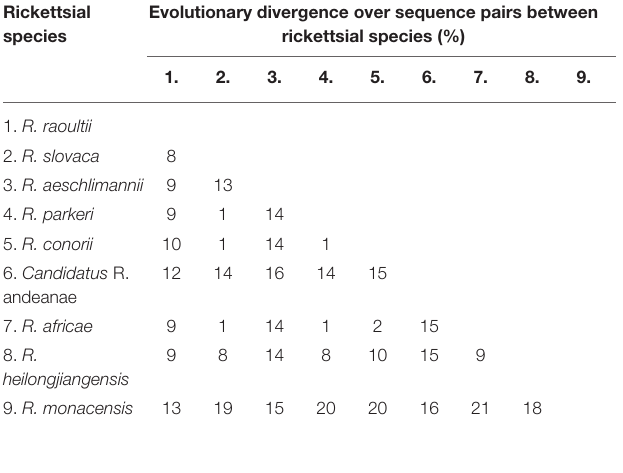
TABLE 5 | Genetic distance matrix among various Rickettsia species in a phylogenetic tree based on the ompA gene in this study. Rickettsial species